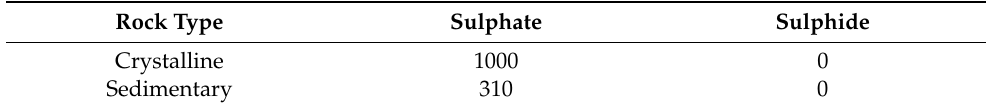
Table 1. Groundwater composition